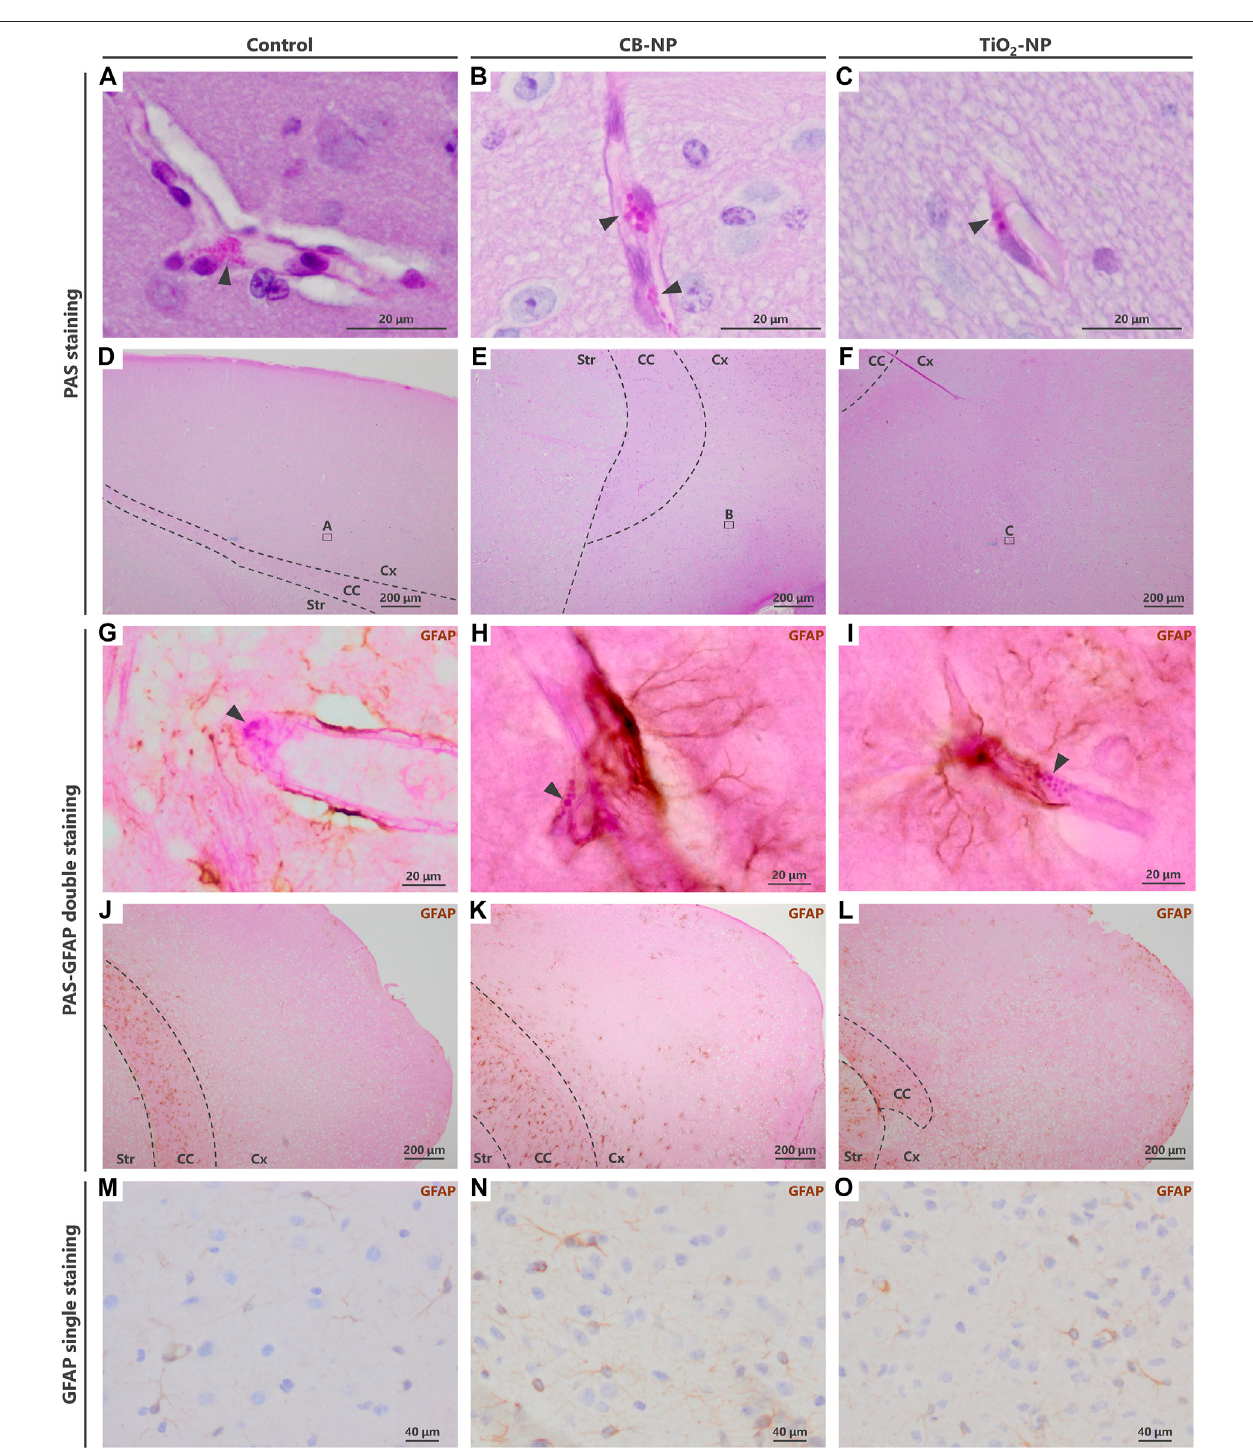
FIGURE 4 | Visualization of enlargement of granules in denatured perivascular macrophages (PVMs). To detect the denaturation of PVMs, their granules were visualizedbyPeriodicacid-Schiff(PAS)staining.IncontrasttoPASsinglestaining,PVMdenaturationwaseasilydetectedbyPAS-immunohistochemicaldoublestaining. (A – F) LightmicrographsofthePVMsstainedwithPASstaining. (A – C) areenlargedpicturesof (D – F) ,respectively.ArrowheadsindicatePAS-positivegranulesinPVMs. Enlargement of the granules was observed after maternal exposure to the nanoparticles. In PAS single staining, the entire brain tissue is stained pink and PVM granules(approximately1 – 3 μ m)areinconspicuous,makingitdif fi culttodetectandevaluatethegranules. (G – L) LightmicrographsofPVMsandastrocytesstainedwith PAS-immunohistochemical double staining. (G – I) are enlarged pictures of (J,K) , respectively. Arrowheads indicate PAS-positive granules in PVM, and brown indicates